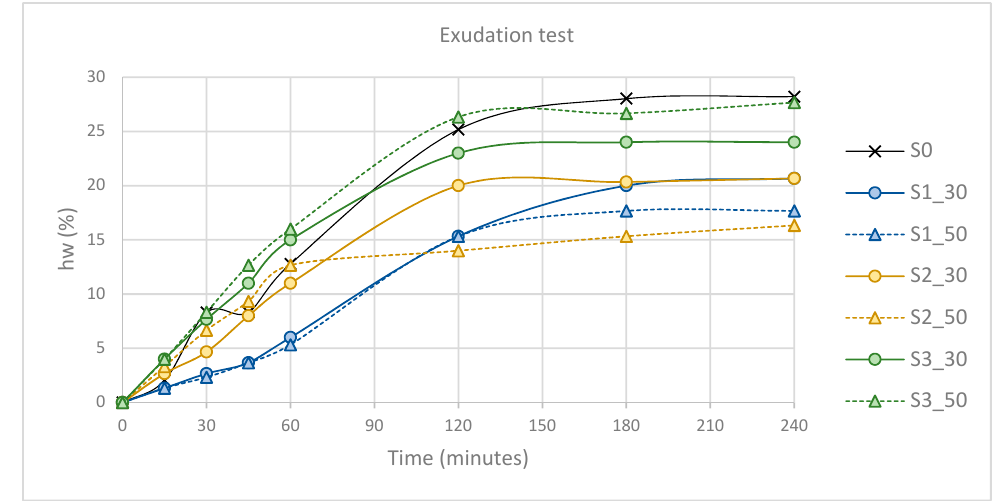
Figure 8. Exudation test.